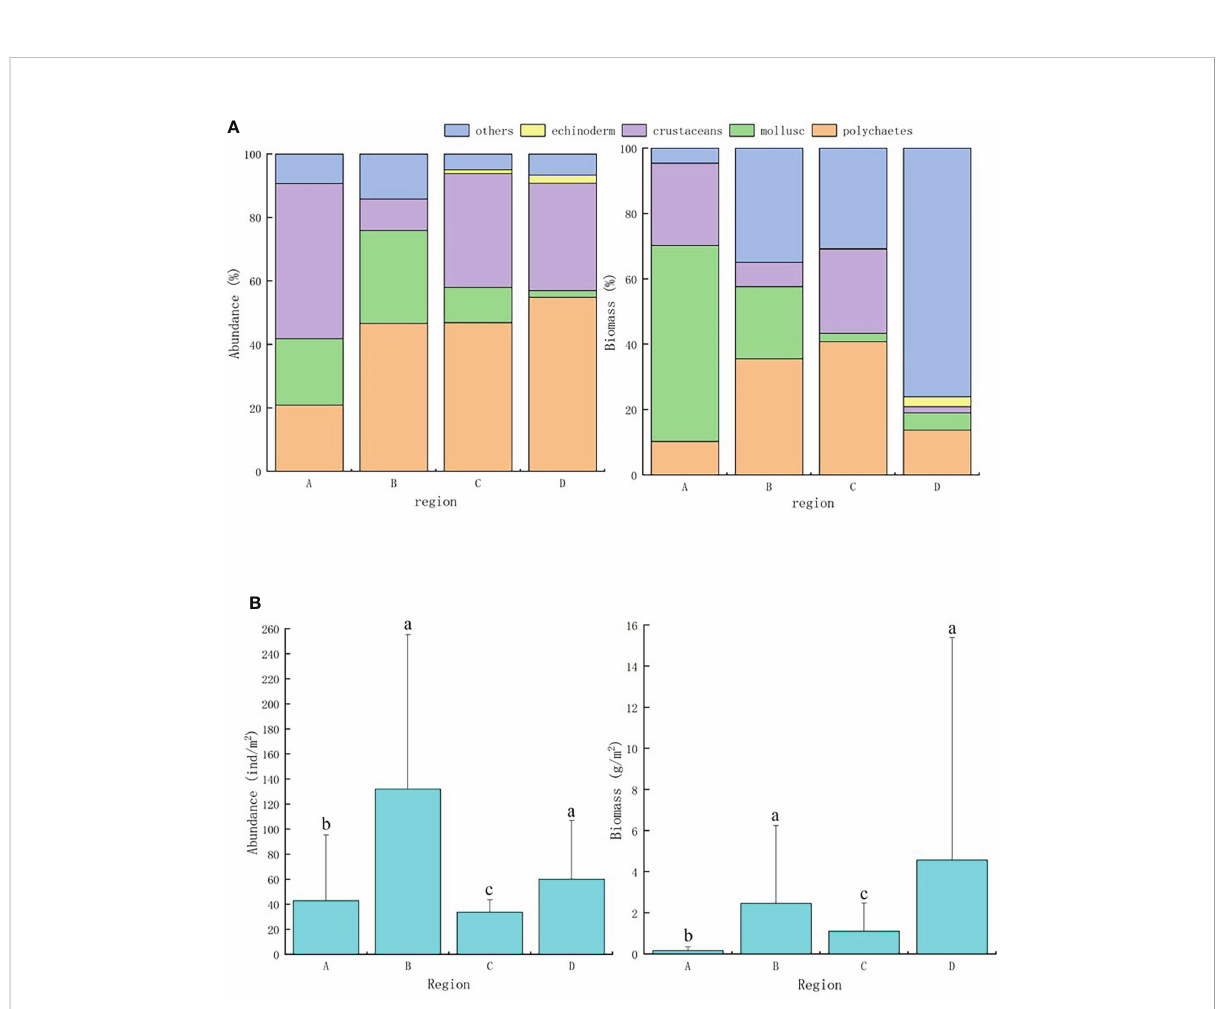
FIGURE 3 (A) Abundance and biomass precent of macrobenthos throughout Hangzhou Bay, (B) Abundance and biomass of macrobenthos throughout Hangzhou Bay. a, b, c represent the difference of multiple